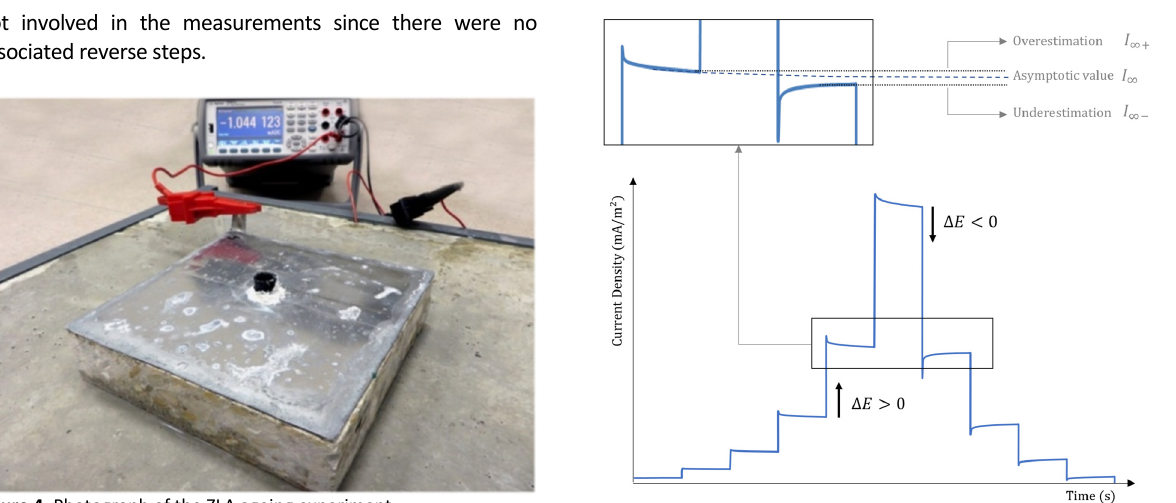
Figure 4. Photograph of the ZLA ageing experiment.